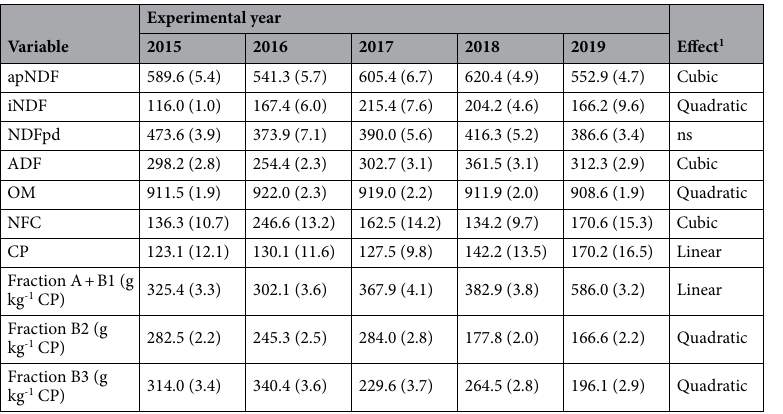
Table 2. Average chemical composition for Marandu palisadegrass (g kg -1 dry matter) affected by year. 1 Orthogonal polynomial effect of N doses. Effect probability (apNDF, P = 0.003; iNDF, P < 0.001; NDFpd, P = 0.11; ADF, P < 0.0001; NFC, P < 0.001; CP, P < 0.001; Fraction A + B1, P < 0.001; Fraction B2, P < 0.001; and Fraction B3, P < 0.01). Within parentheses is the standard error of the means (SEM; ±).